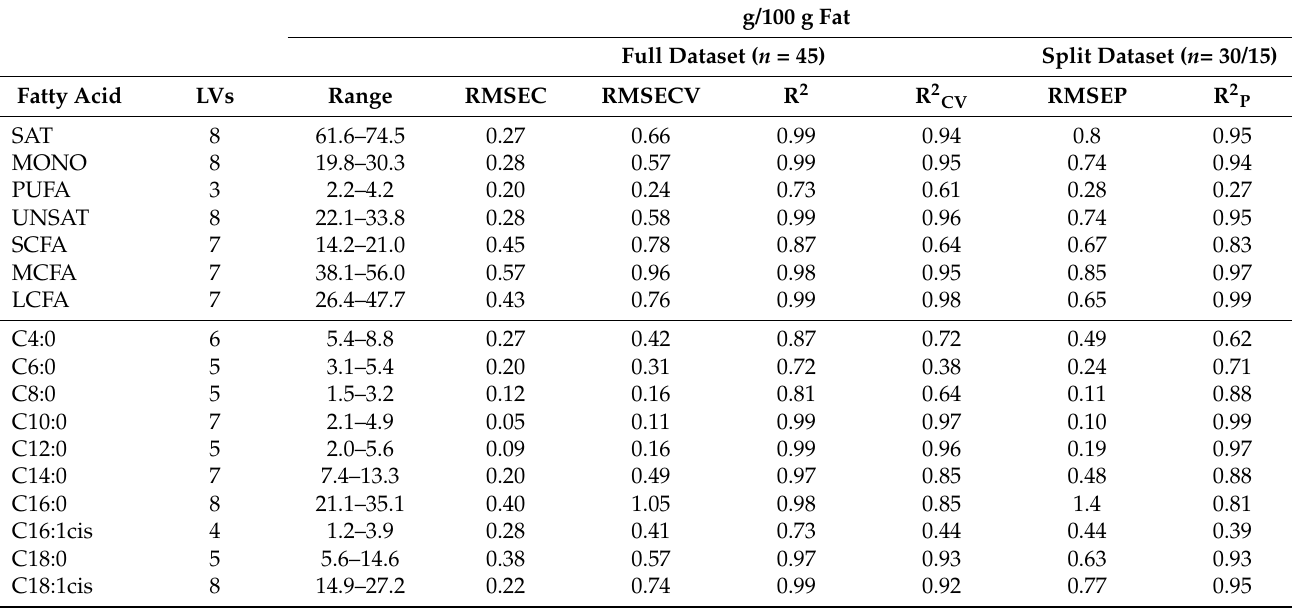
Table 2. Statistical parameters for each individual calibration equation estimating relative individual fatty acid concentration and relevant sum parameters in g/100 g of